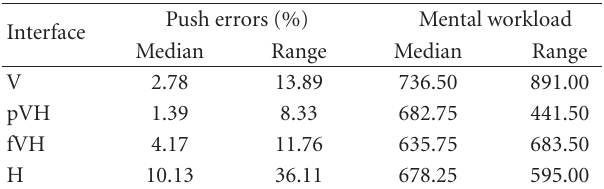
Table 2: Median and range of push errors and mental workload for each